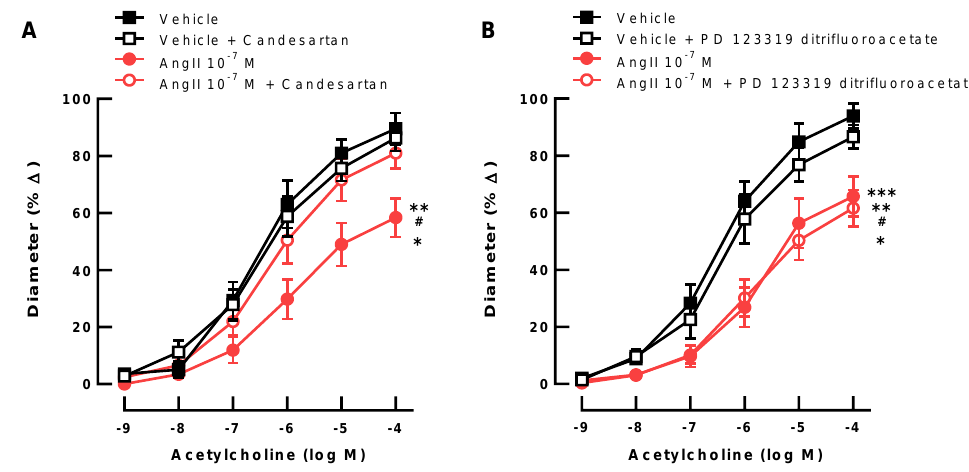
Figure 2. The AT1R blocker, candesartan, prevented Ang II-induced endothelial dysfunction ( A ) ( n = 8 per group; ** p < 0.01, Ang II 10 − 7 M versus vehicle; # p < 0.01, Ang II 10 − 7 M versus vehicle + candesartan; * p < 0.05, Ang II 10 − 7 M versus Ang II 10 −7 M + candesartan). The AT2R blocker, PD 123319 ditrifluoroacetate, had no effect on Ang II-induced endothelial dysfunction ( B ) ( n = 8 per group; *** p < 0.001, Ang II 10 −7 M + PD 123319 ditrifluoroacetate versus vehicle; ** p < 0.01, Ang II 10 −7 M versus vehicle; # p < 0.01, vehicle + PD 123319 ditrifluoroacetate vs. Ang II 10 −7 M + PD 123319 ditrifluoroacetate; * p < 0.05, vehicle + PD 123319 ditrifluoroacetate vs. Ang II 10 −7 M). Data are expressed as mean ± SE.